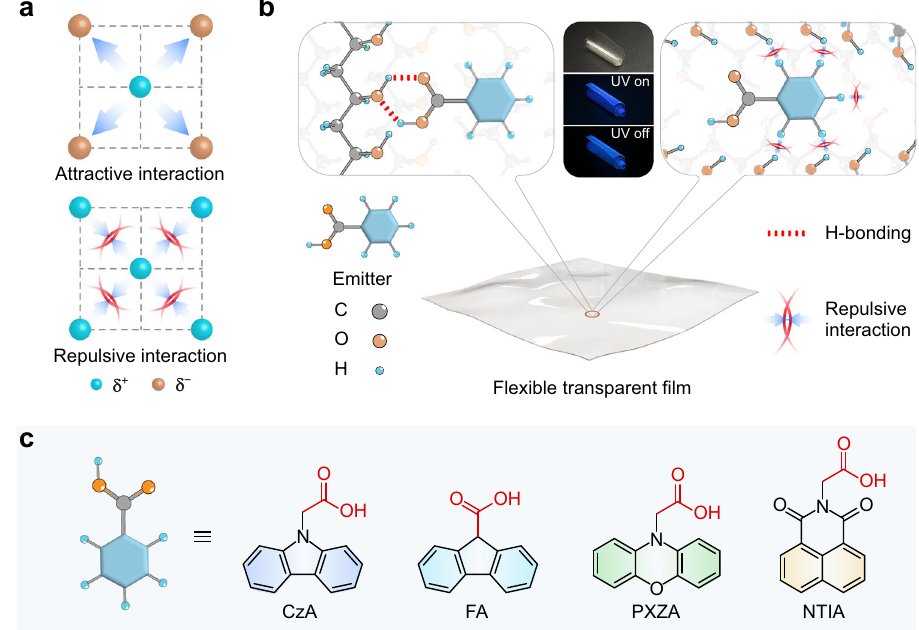
Fig. 1 | Schematic illustration of the isolated emitter doping into the fi lm for UOP.a Demonstration of stabilizing molecules by attractive (top) and repulsive (bottom) interactions. b Intermolecular interactions between the emitters and polymer matrix in fi lm. The schematic diagram of hydrogen bonding between the polymer chain and carboxylic group (left) as well as the repulsive